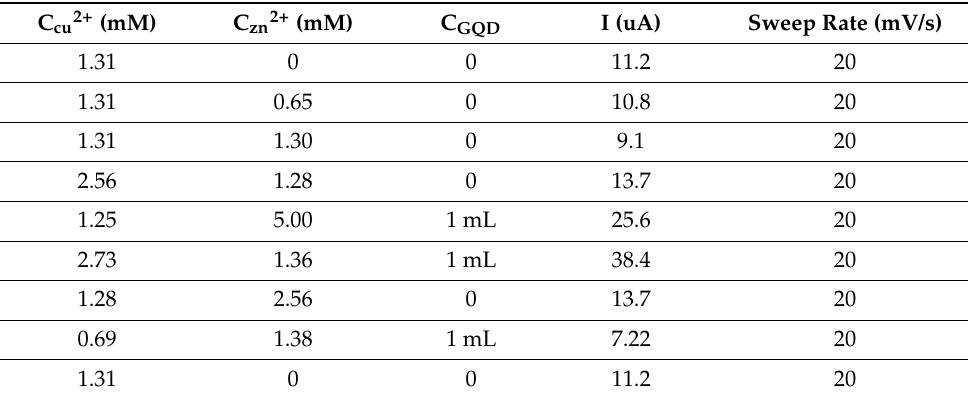
Table 1. The measured currents from the cyclic